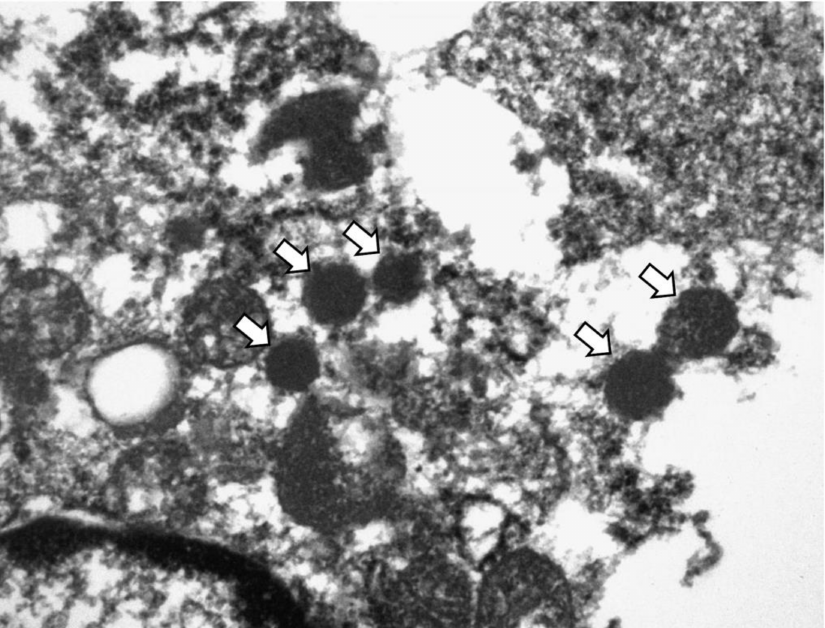
Figure 4. Transmission electron microscopy image of synaptophysin-negative SCNEC. Arrows indicate neurosecretory granules (218.31–275.16 nm). (Original magnification, ×